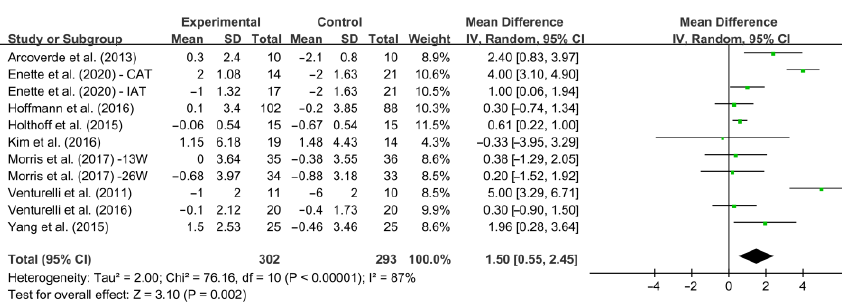
Figure 4. Meta-analysis results of the effect of aerobic exercise on cognitive function in AD patients [20,27,39 – 45].